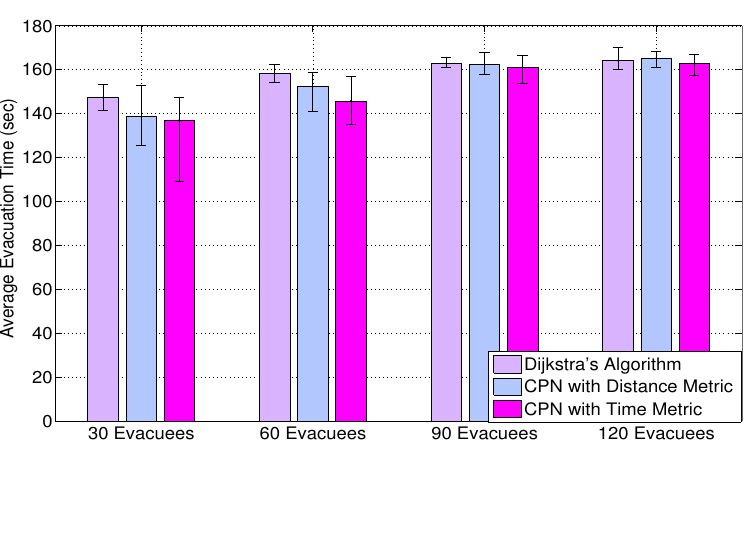
Figure 6. The average evacuation time of ten iterations in arbitrary time units. The error bars represent the min/max values found in the 10